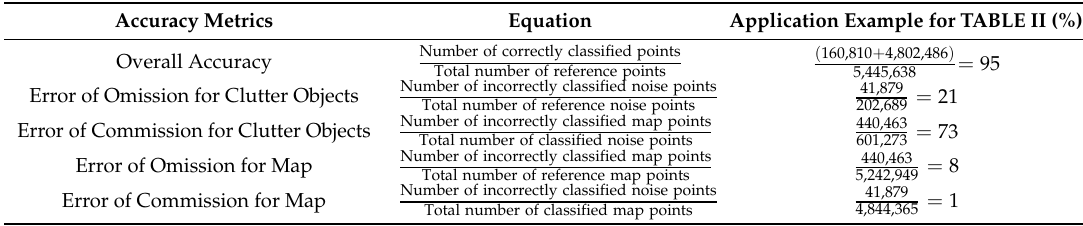
Table 3. Equation for Accuracy Metrics and the application